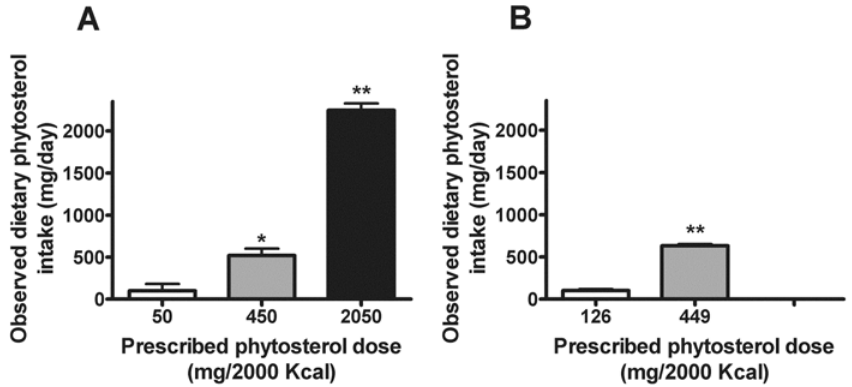
Fig 2. Observed dietary phytosterol intake (DPI) (A, Supplement Study; B, Natural Study). * significantly different from 50 mg/2000 Kcal, P < 0.01; ** significantly different from 50 mg/2000 Kcal or 450 mg/2000 Kcal (A), or from 126 mg/2000 Kcal (B), P <